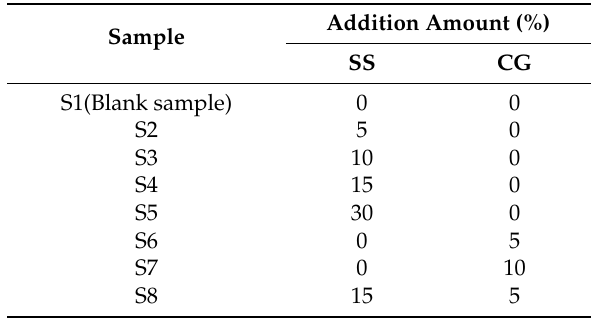
Table 2. The addition amount of sewage sludge and coal gangue in raw meal. Addition Amount (%) Sample